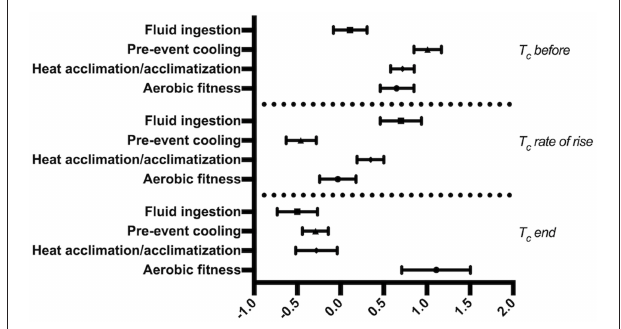
FIGURE 2 | Forest plot of Hedges’ g weighted averages of heat mitigation strategies effect on T c at different points.